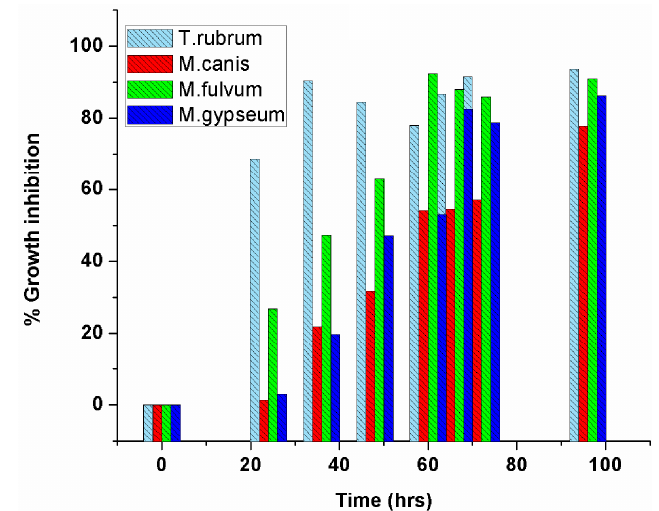
Figure 5. Comparative swelling index of fabricated D1, D2, and D3 nanofibers over 24 h ( a ); In vitro drug release profile of drug-loaded nanofibers in simulated phosphate buffer, pH 6.8, for 8 h ( b ).